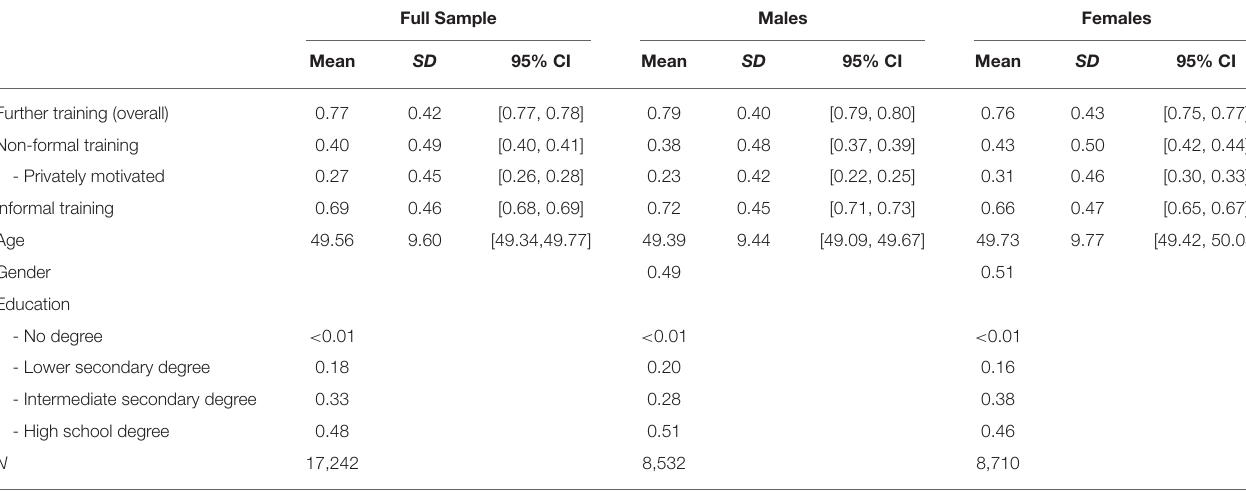
TABLE 1 | Summary